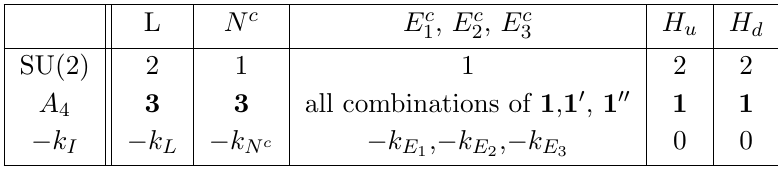
Table 14 . Charge assignment of the lepton sector and Higgs